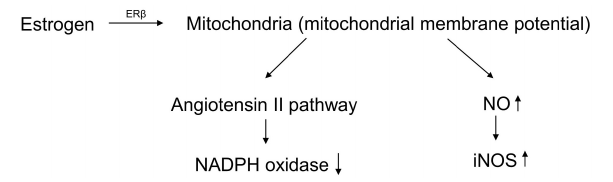
FIGURE 1 | The antioxidant effect of